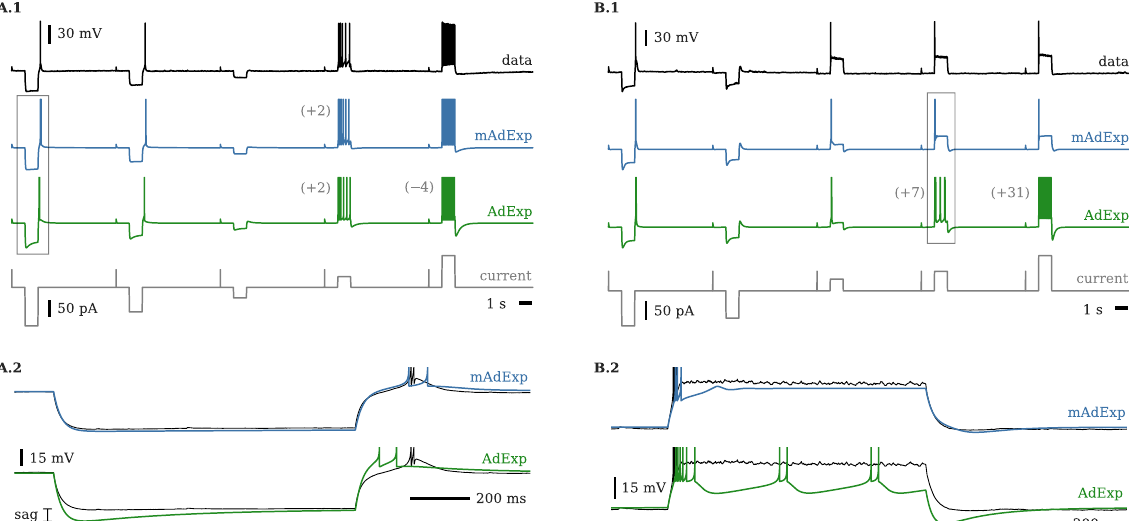
Fig 7. Voltage traces for two cell types (566978098 and 570896413 in Allen Brain Atlas) and associated fits with mAdExp and AdExp neuron models. Fourth row represents the input current. Additional or missed spikes are marked in parentheses on the left of the associated spike train. Activities in the rectangles are expanded in the lower panels. A. Cell presenting little to no sag upon hyperpolarization and adaptive spiking behavior (A.1); expanded activity (A.2) enables to see the discrepancies between the AdExp model (green) and the data (thin black line) while mAdExp (blue) matches the dynamics much more precisely. B. Cell presenting significant sag upon hyperpolarization and almost immediate depolarization block upon depolarizing input (B.1). Both AdExp and mAdExp match the rebound dynamics; however, AdExp cannot reproduce the depolarization block as shown in the expanded dynamics (B.2). See 5 for detailed